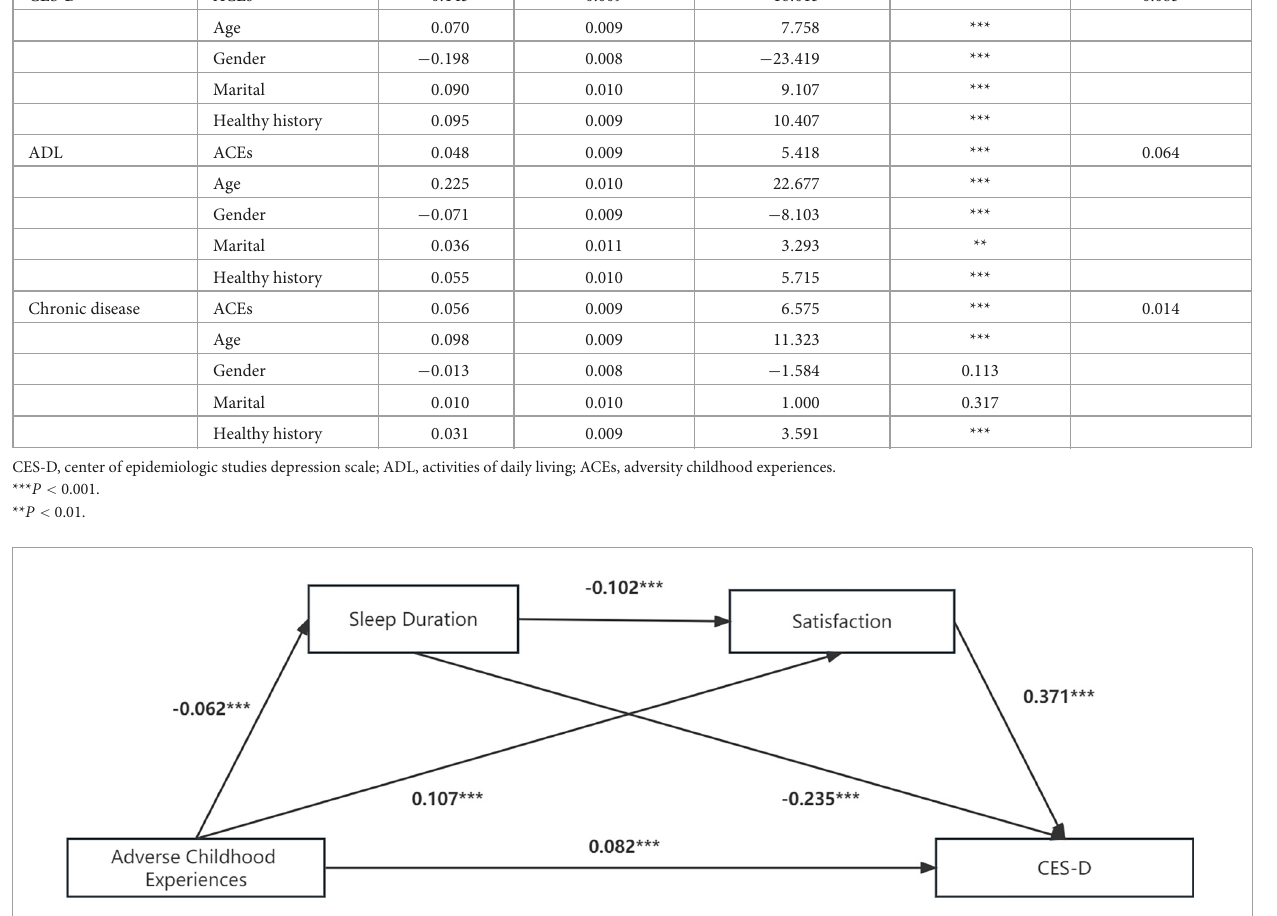
RMSEA = 0.066, SRMR = 0.014. Table 6 shows the total effect, direct effect, indirect effect and their 95% confidence interval (CI), in which the effect value of ACEs on depression symptoms through sleep duration is 0.014, accounting for 10.5% of the total effect. Furthermore, the effect value of ACEs on depression symptoms through life satisfaction was 0.040, accounting for 28.8% of the total effect. The effect value of